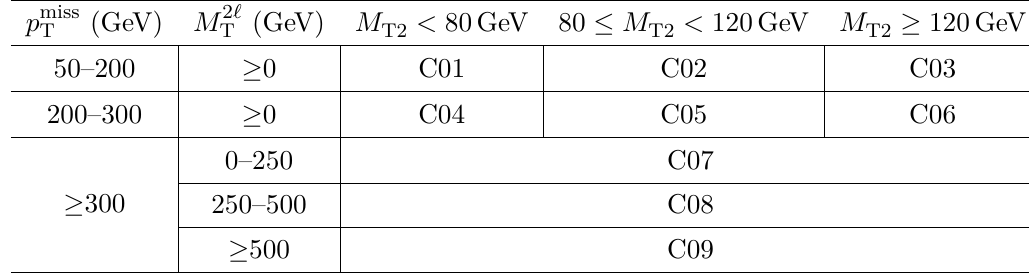
Table 6 . Definition of the search regions for events with a m + m − or e + e − pair and an additional t h candidate